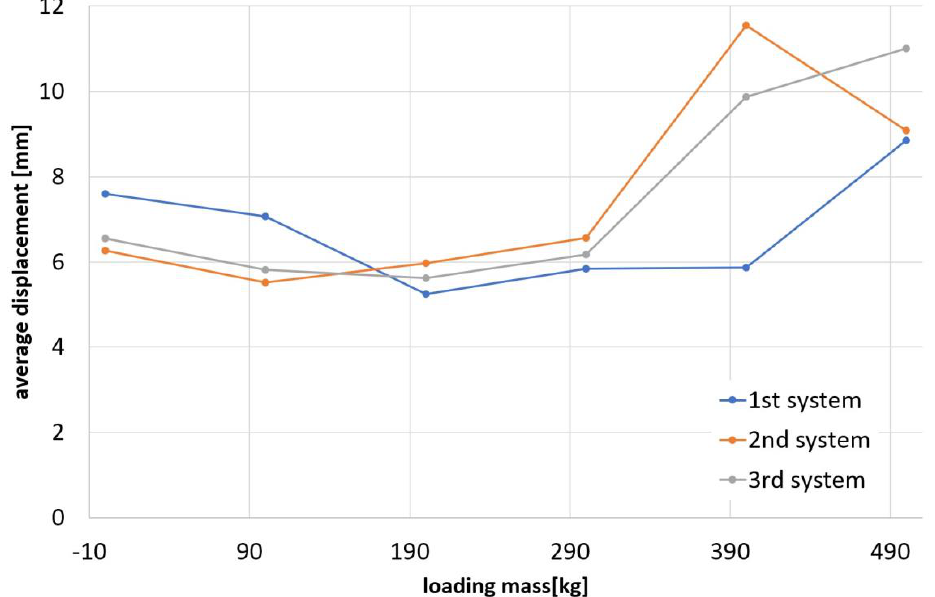
Figure 9. Average cylinder piston rod displacement values recorded after the initiation of the stopping process, expressed as a function of the loading mass.